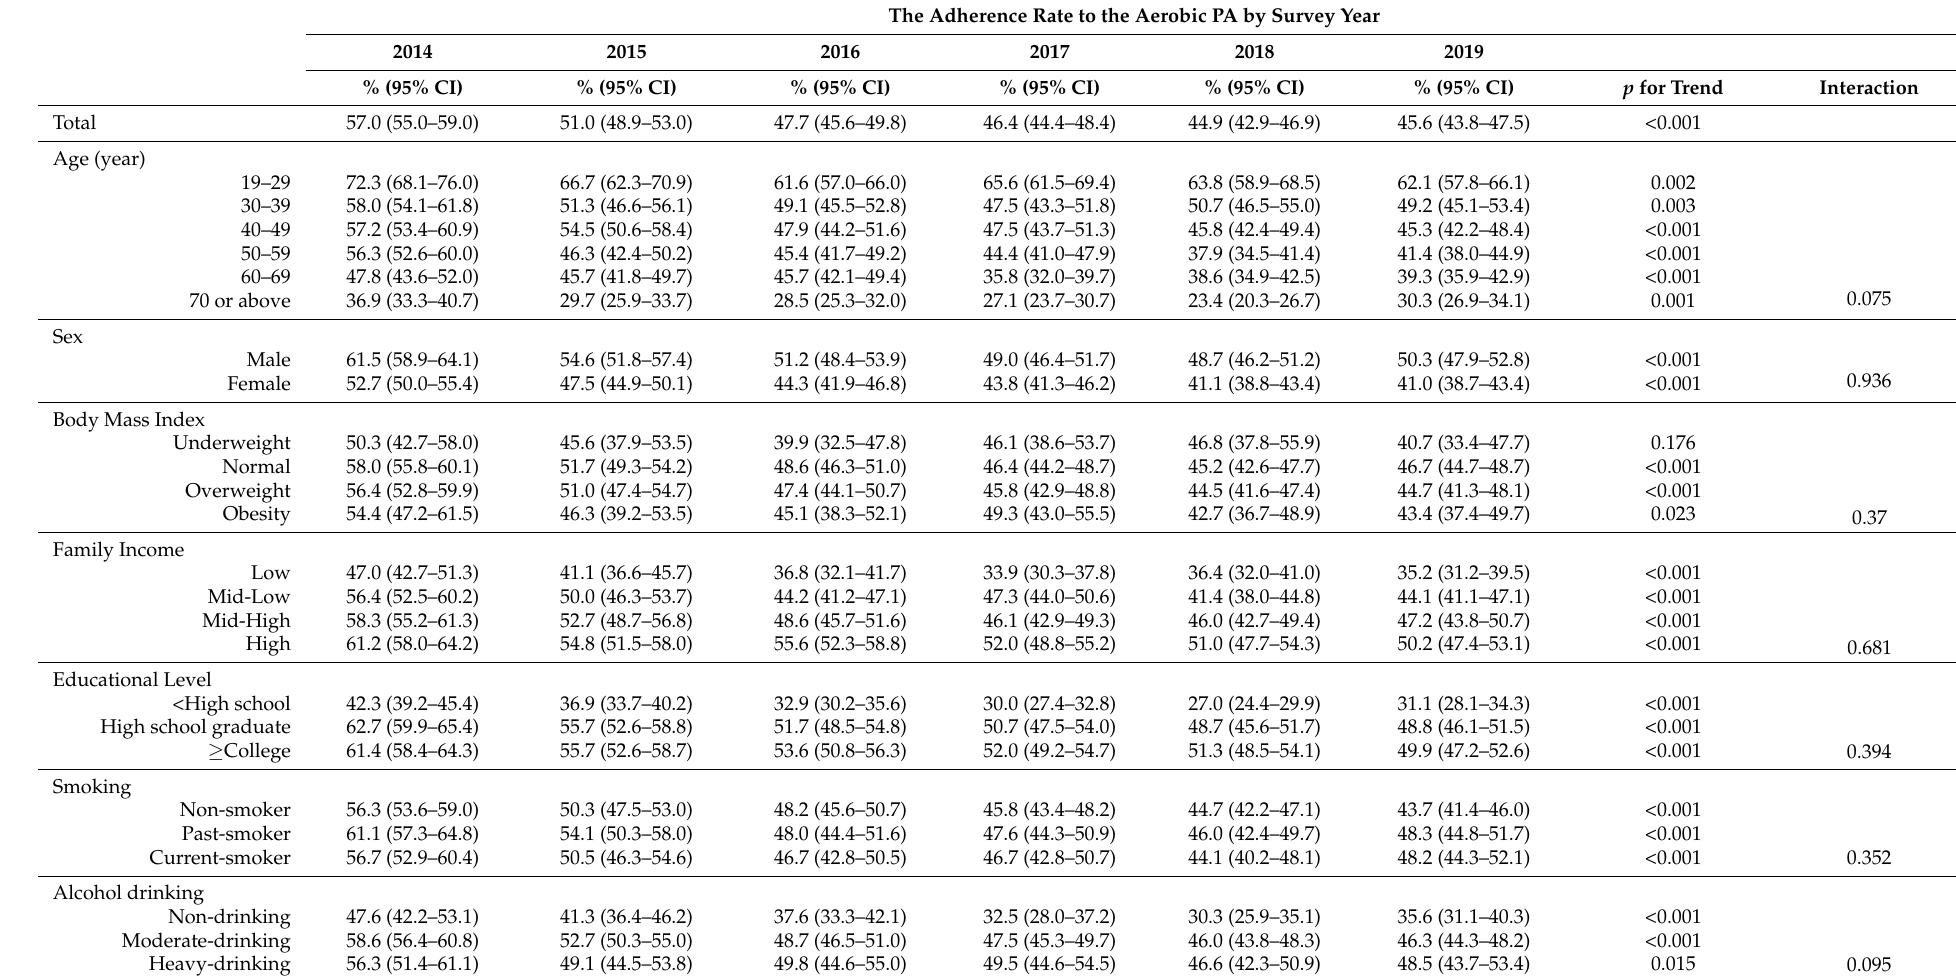
Table 2. Changes in adherence rate to the aerobic PA guideline by survey